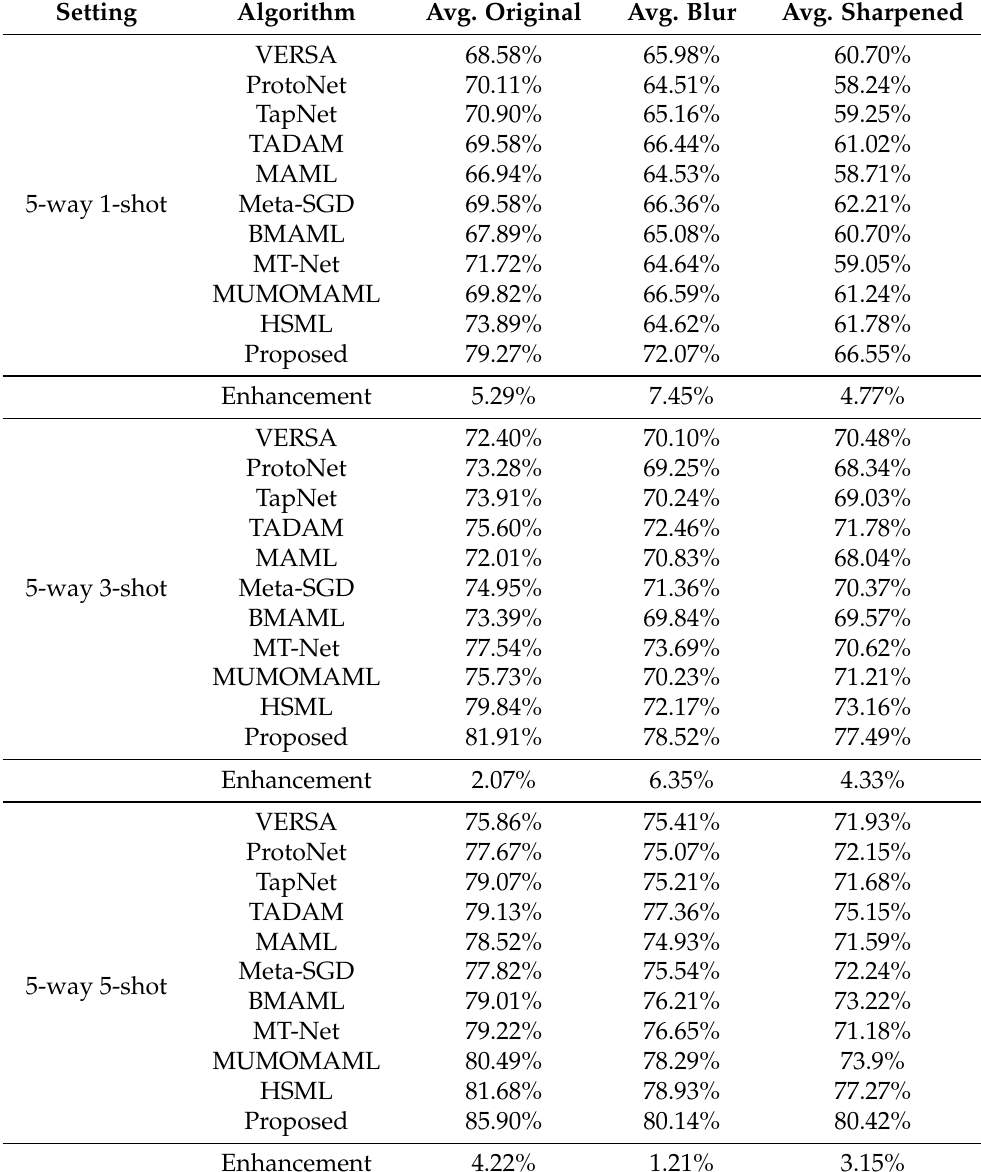
Table 5. Comparison of the few-shot classification accuracy of task-covariant learning, task-invariant, and task-heterogeneous methods on the degraded AID